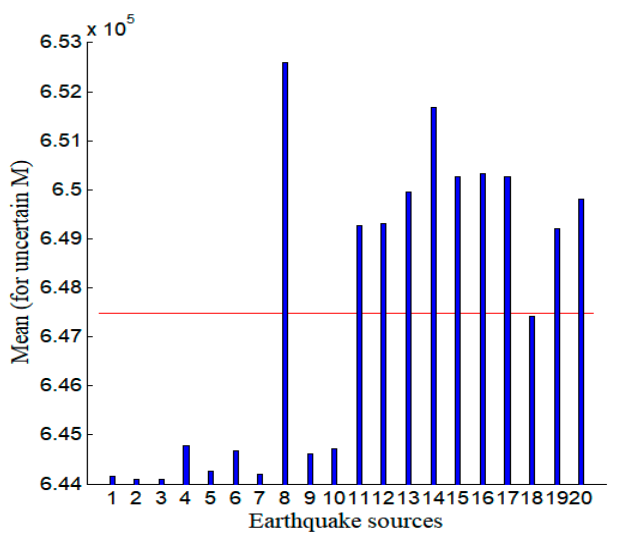
Figure 11. Distribution of mean TSTT according to earthquake sources for uncertain earthquake magnitudes.